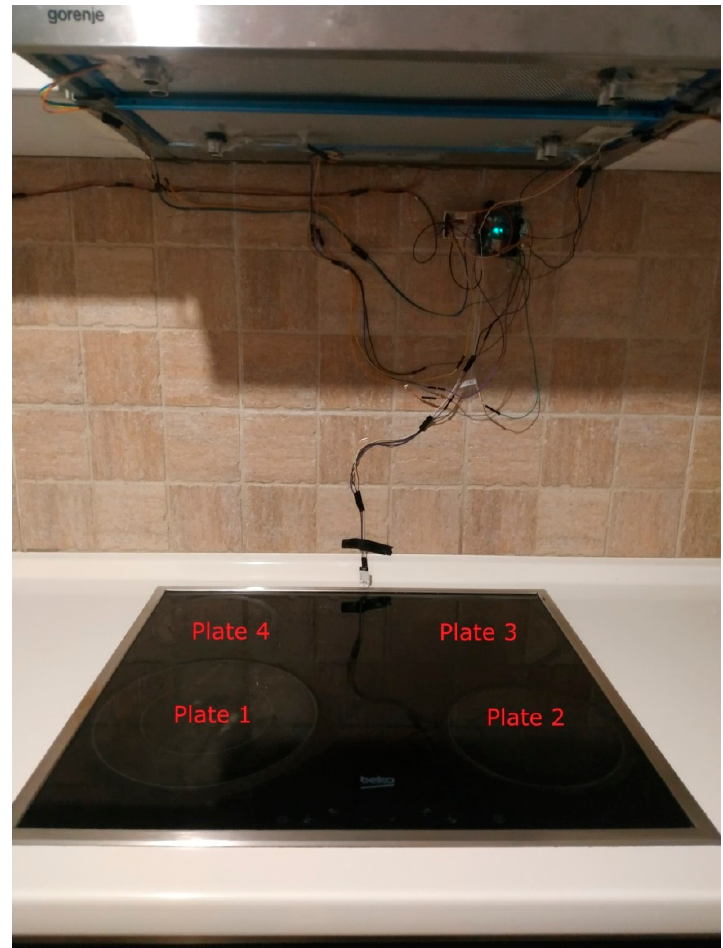
Figure 3. Experimental setup at hotplate location.